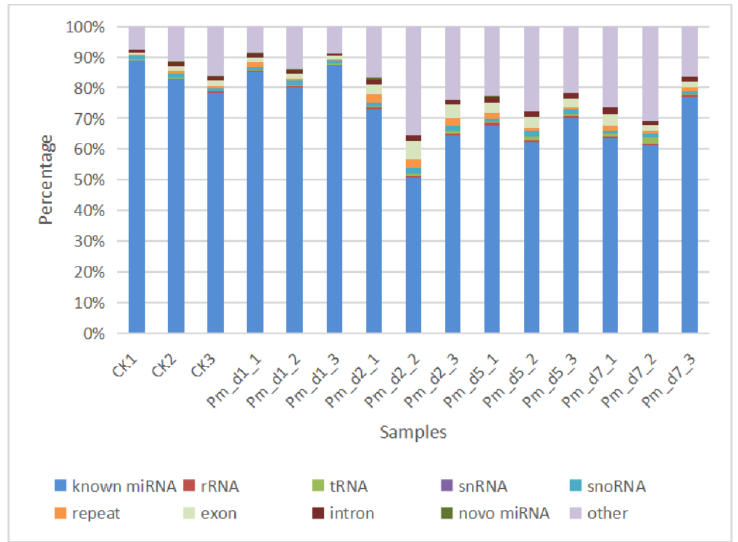
Figure 3. Different categories of small RNAs results are shown for each goat involved in the study ( n = 3).